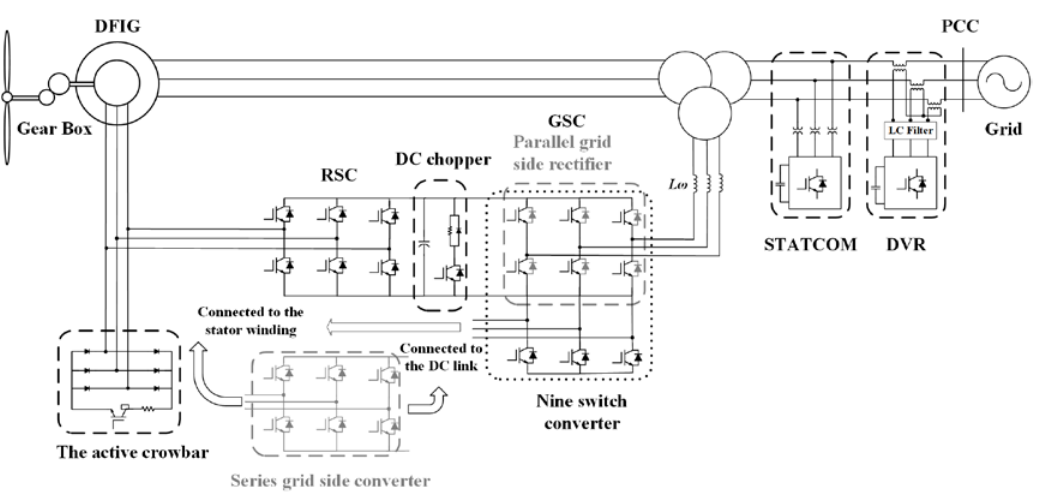
Figure 4. The doubly-fed induction generator (DFIG) configuration with the most well-known fault ride-through (FRT) enhancement approaches. DVR: Dynamic voltage restorers; STATCOM: Static synchronous compensator.